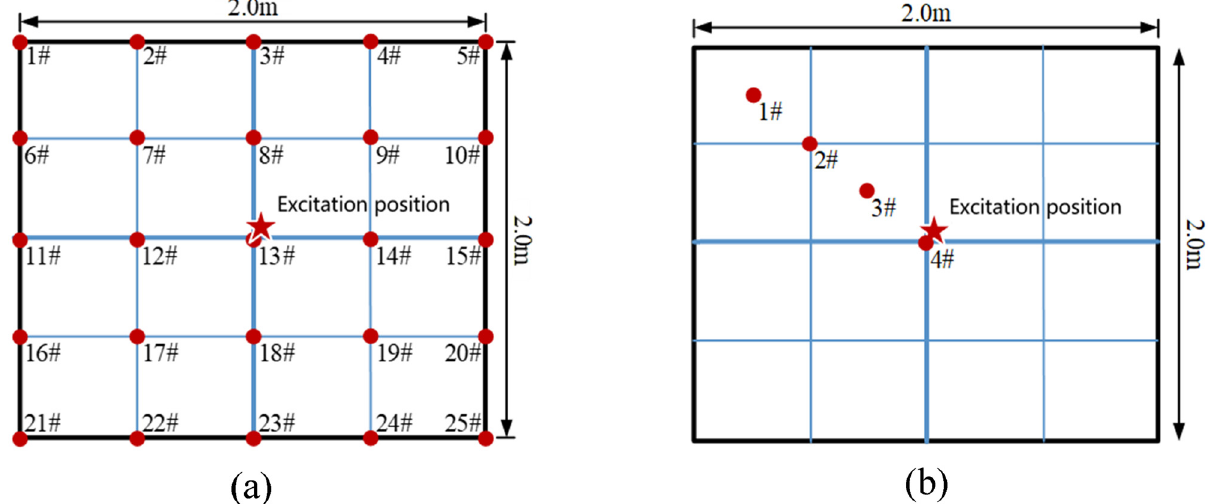
Figure 3: Schematic diagram of measuring point layout: ( a ) modal test points arrangement; ( b ) transmission characteristic test points arrangement.